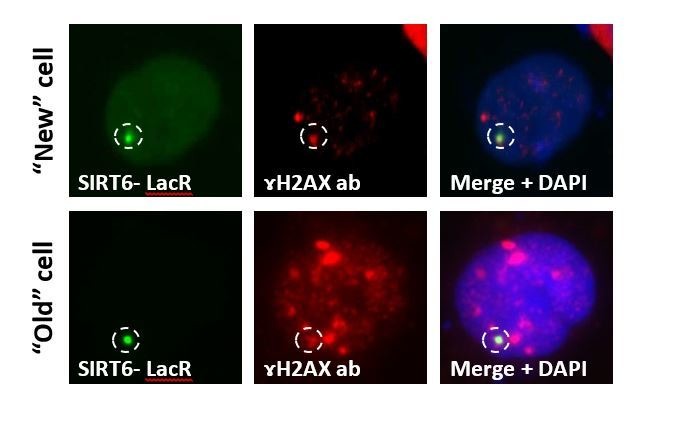
IF for ɤH2AX in in SIRT6-LacR-GFP expressing U2OS cells.“New” vs. “Old” cells.